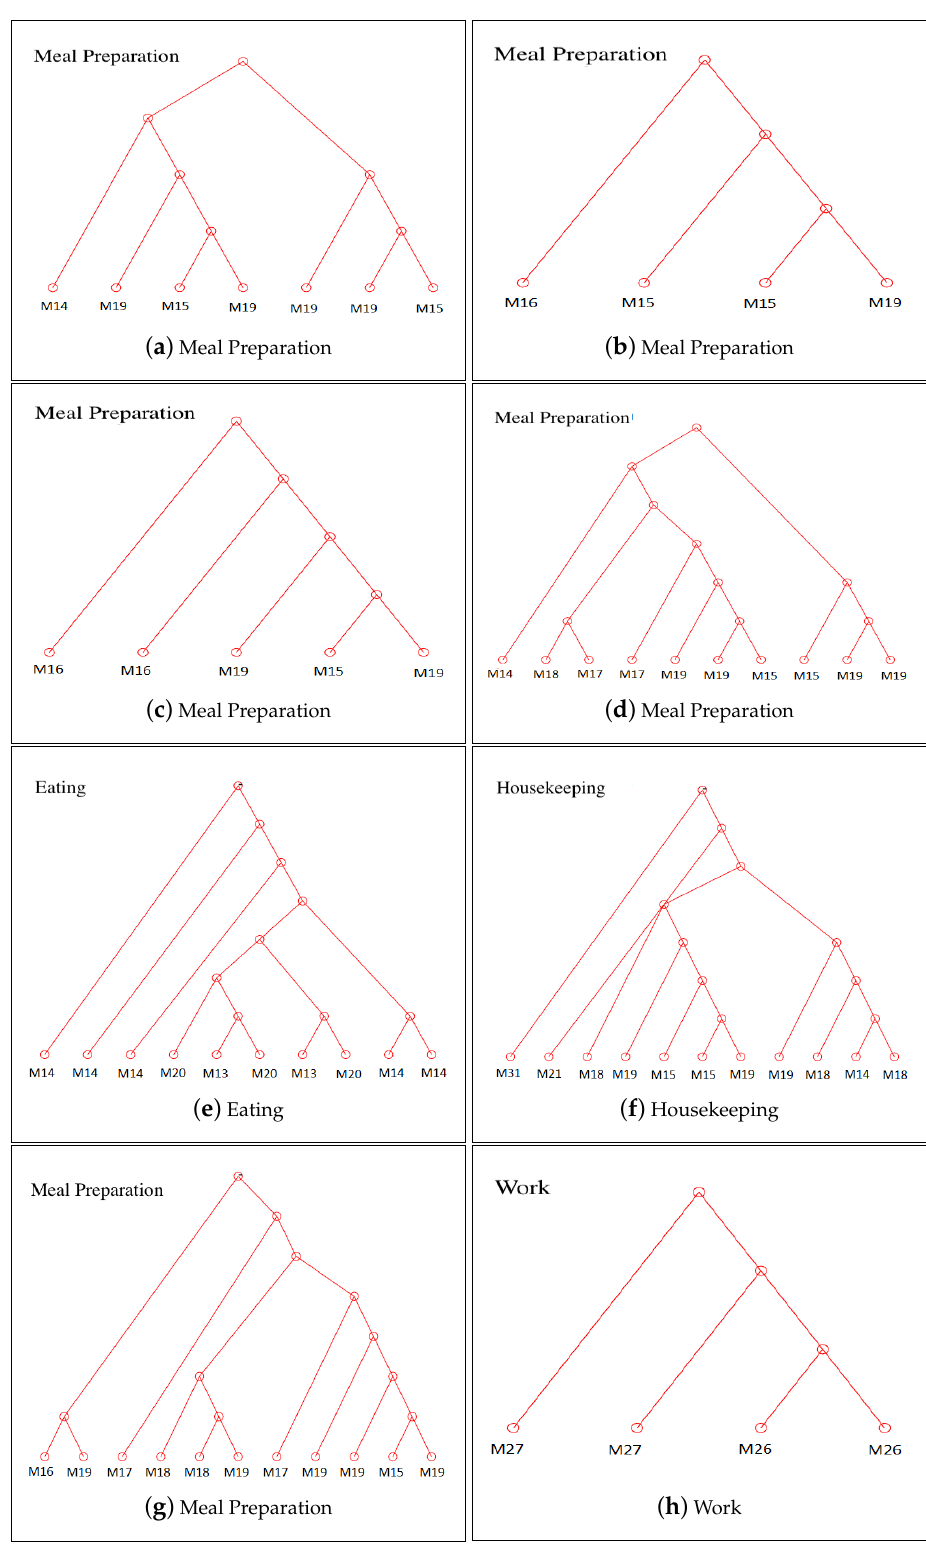
Figure 8. RAE trees constructed with the training